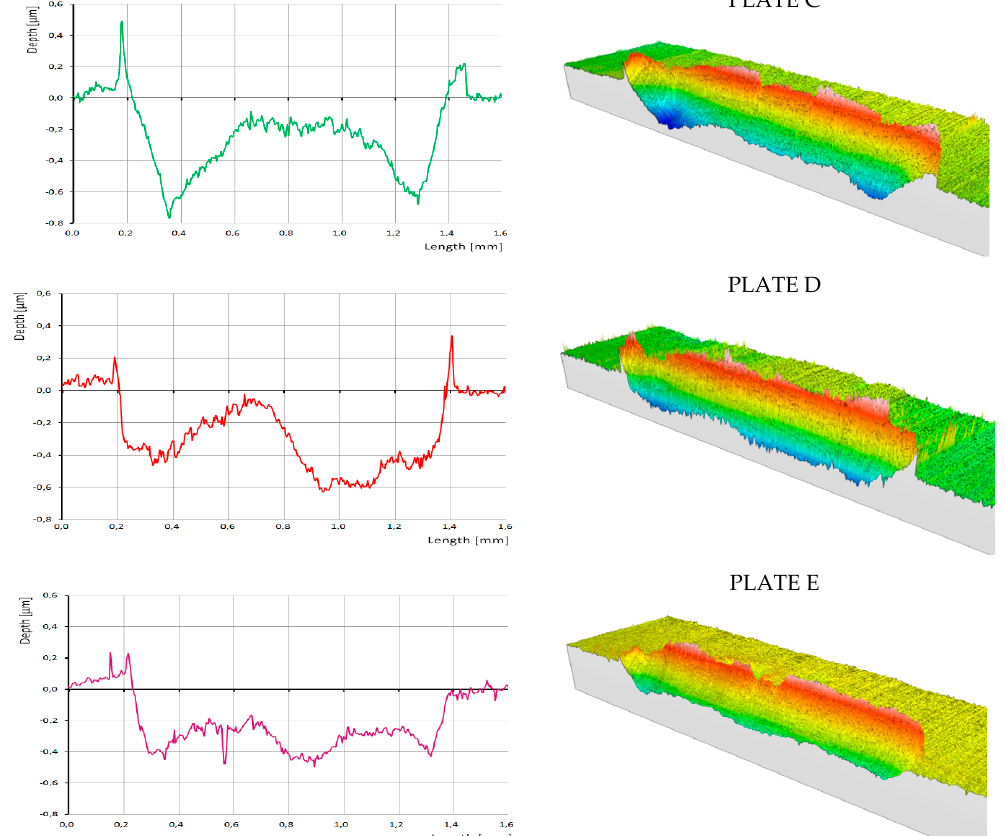
Figure 4 . Longitudinal central trace of the friction track, as measured with a tactile profilometer (left), and the corresponding 3D topography image obtained from multiple longitudinal traces; a uniform scale bar and color assignment were used for all samples presented here.